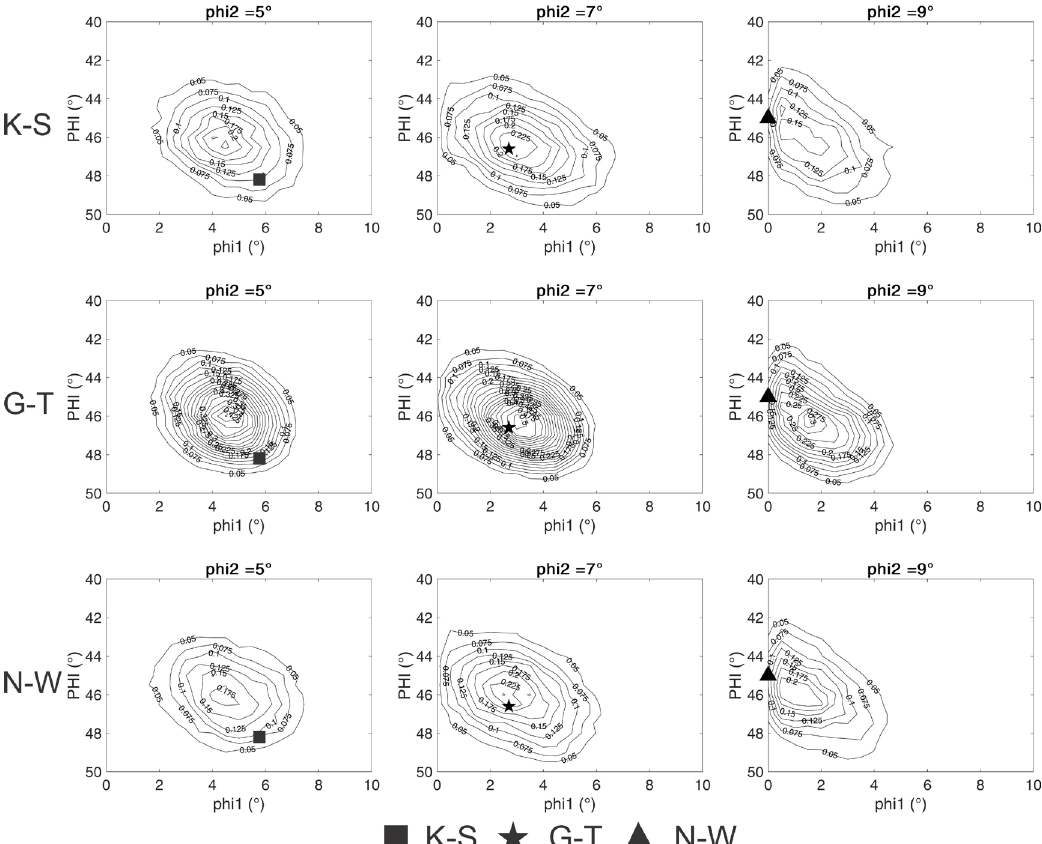
Figure 4. Sample after air-quenching treatment: misorientation distribution between the martensite and prior austenite reconstructed using K-S, G-T and N-W ORs.